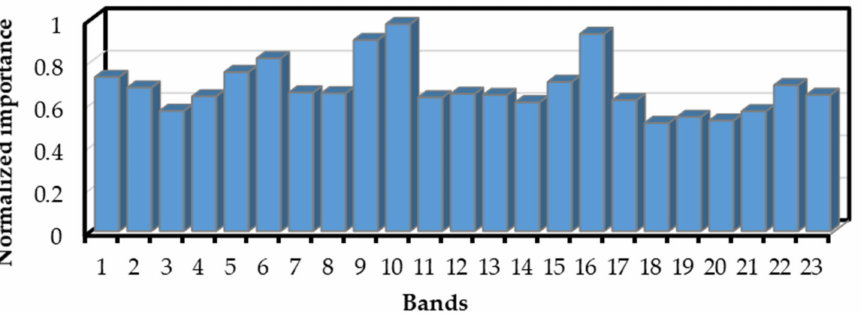
Figure 5. The normalized importance assessment of the crop classification features selected that satisfied the separability